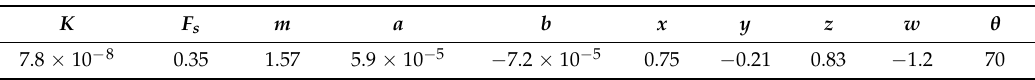
Table 2. The erosion sub-model parameters used in erosion